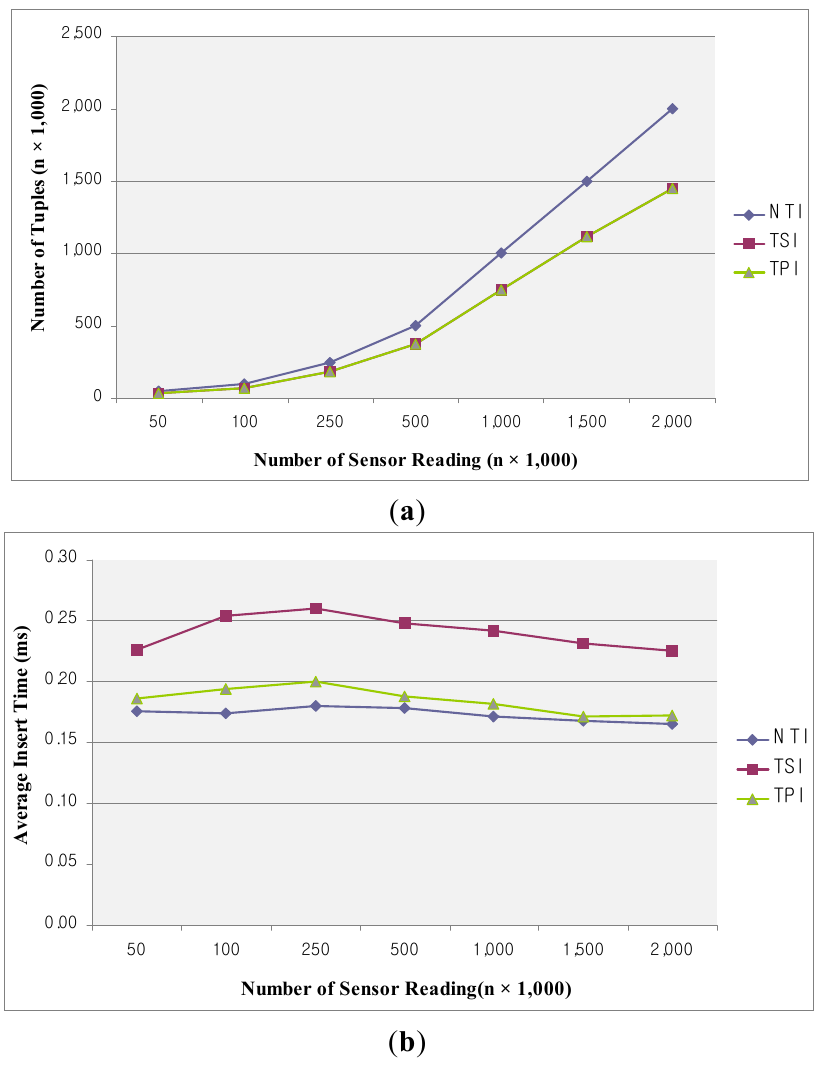
Figure 12. The number of tuples as a function of the number of sensor readings ( a ); and Average insert time as a function of the number of sensor readings ( b